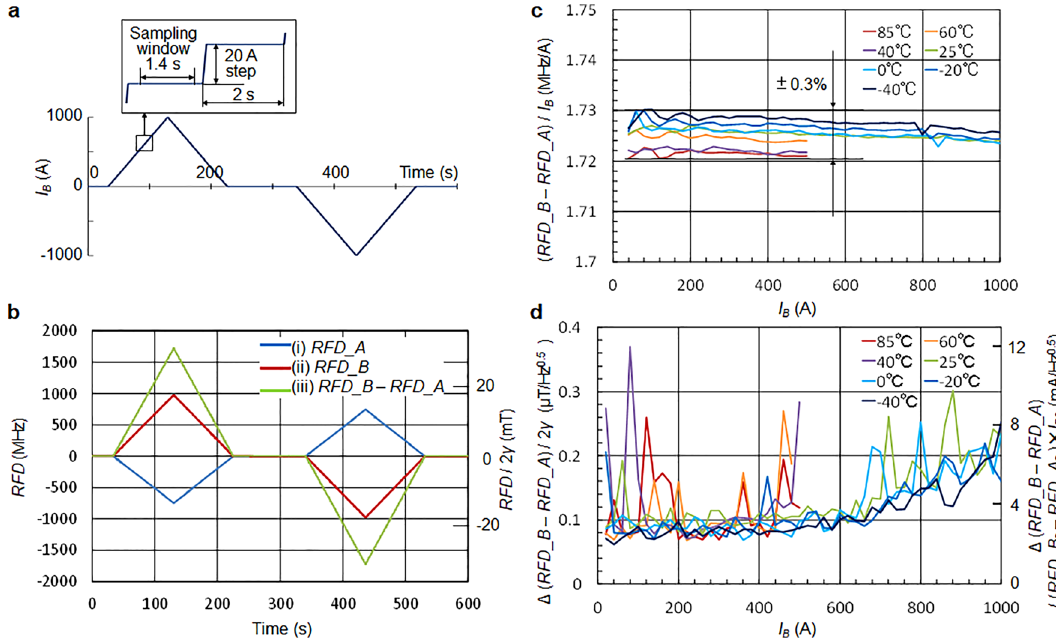
Figure 6. Large current measurement from external source. ( a ) ± 1000 A input current waveform to the busbar stepped by 20 A in each 2 s. The sampling window was cut out from each step, excluding the transient response portion. ( b ) Observed resonance frequency difference ( RFD ), RFD_A (blue line), RFD_B (red line), and ( RFD_B − RFD_A ) (green line). All waveforms are correctly tracing the busbar current. ( c ) The ratio of average value of ( RFD_B − RFD_A ) within the sampling window vs. busbar current in each step. ± 0.3% linearity was confirmed in the current range from 40 to 1000 A and the temperature range from − 40 to + 25 °C as well ratio of ( RFD_B 0 − RFD_A 0 )/ I B0 (1.72 MHz/A), where ( RFD_B 0 − RFD_A 0 ) is ( RFD_B − RFD_A ) at I B0 = 1000 A. Neglecting some noise spikes, which are assumed to originate from the programmable ± 1000 A current